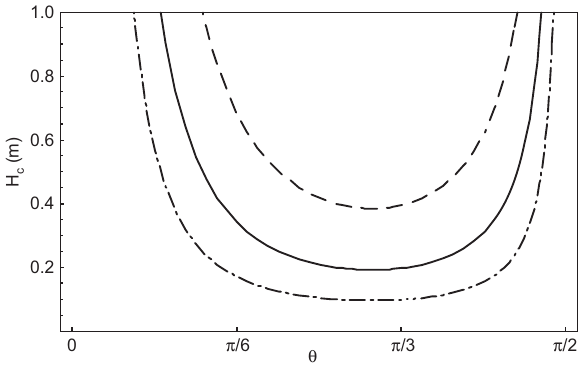
Figure 3 Predictions of the critical height of the fallen snow for avalanche triggering vs. slope. Different curves refer to different ini- tial lengths (2a) of the super-weak zone: 1.5 m (dashed line); 3 m (continuous line) and 6 m (dash-dotted